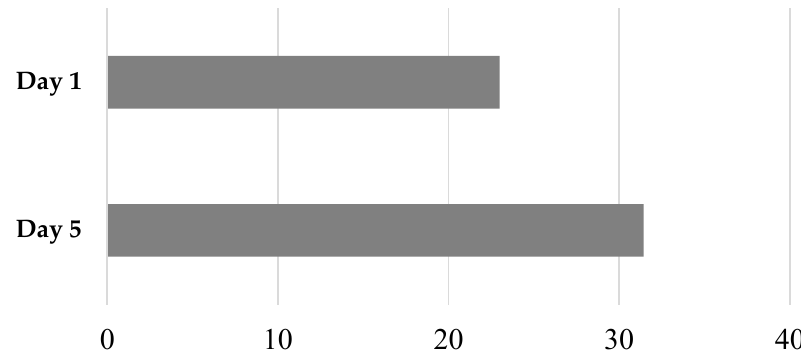
Figure 2. Improvement in trauma symptoms with MHFA. Table 2. Improvement in trauma symptoms by location for the four largest disasters/campsites.